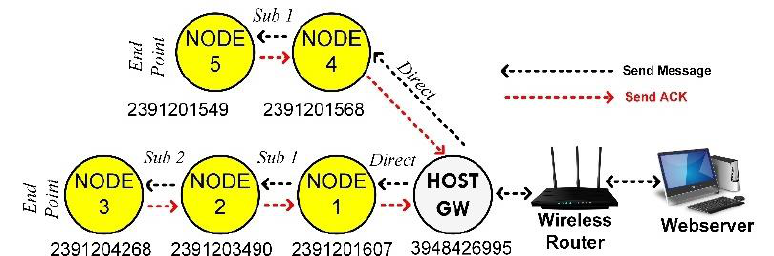
Fig. 3. ESP-Mesh Network Architecture for testing purpose